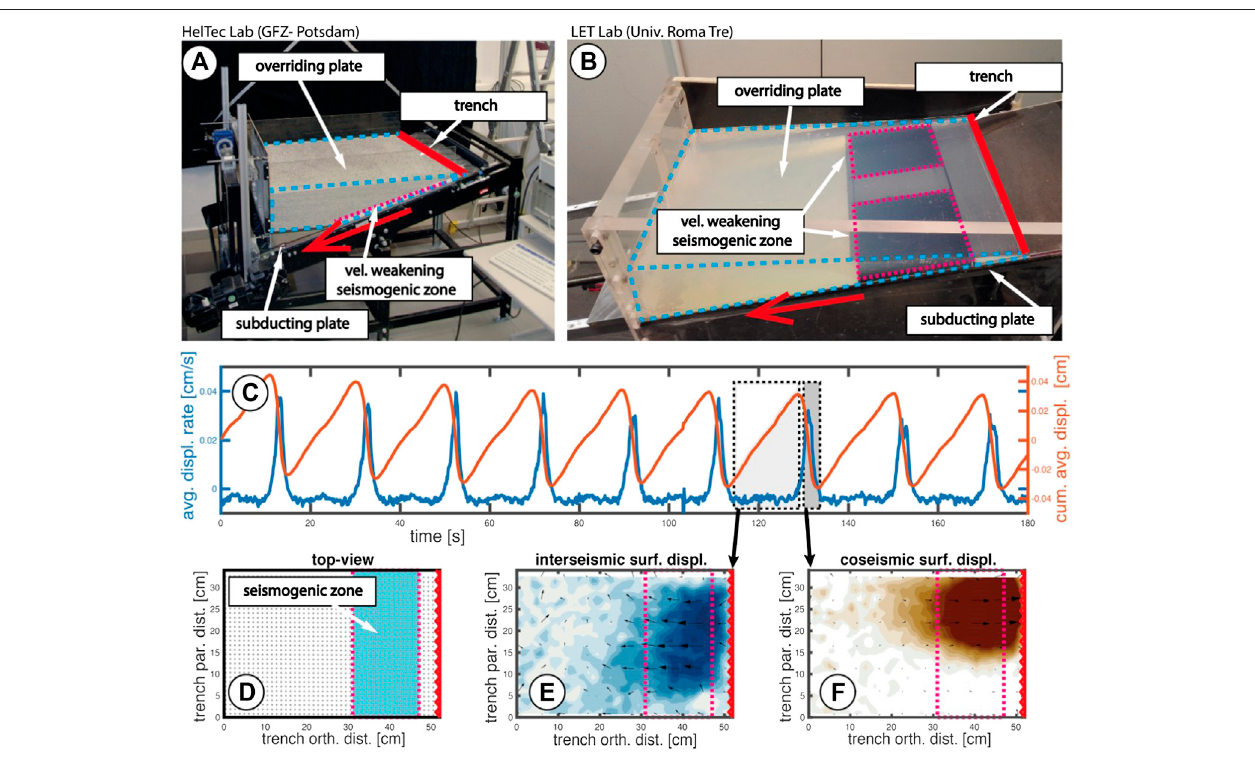
FIGURE 2 | Digital photos of seismotectonic analog model setup from the HelTec (A) and LET (B) labs (modi fi ed from Rosenau et al., 2017; Corbi et al., 2017a, respectively). Both setups are made of a glass-sided, wedge shaped box whose base is inclined 10 ° – 15 ° in agreement with natural observables of subduction mega thrusts (Heuret et al., 2011). Both are equipped with a basal conveyer plate moved by a motor-driven piston with variable velocities of the order of 10 4 – 10 − 5 m/s as analogue, analog of the downgoing subducting plate. HetTec models use a mix of granular material composed by rice, sugar and rubber pellets to simulate an elastoplastic continental lithosphere and silicone oil to simulate the mantle. LET models are made of a visco-elastic gelatin which is deformed on the velocity-weakening seismogenic zone of the subduction thrust which simulated by sandpaper at the gelatin-basal plate interface. Both models experience stick-slip dynamics [orange time series in (C) ] as response to subducting plate underthrusting. Particle Image Velocimetry allows monitoring the evolution of the displacement fi eld as in a dense, homogeneously distributed geodetic network [gray dots in (D) ], spanning also above the generally offshore seismogenic zone [cyan rectangle in (D) ]. The average surface displacement rate time series [blue time series in (C) ] is characterized by phases of relatively slow, landward displacement rates, analog of interseismic phases [displacement fi eld shown in (E) ], alternating with trenchward velocity peaks, analog of coseismic phases [displacement fi eld shown in (E) ].